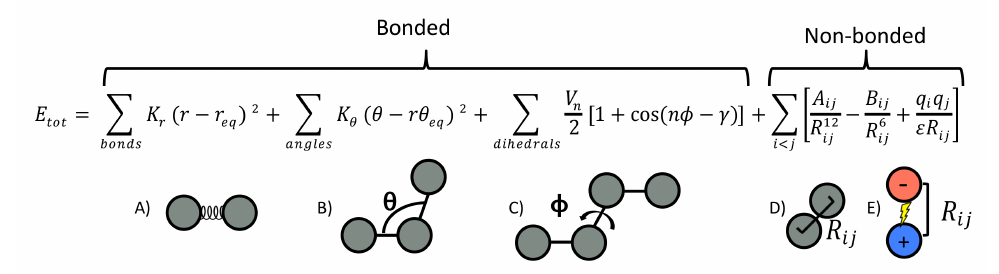
Figure 1. A typical force field (FF) model. Energy dependencies are related to (a) stretching or compressing a bonded pair of atoms (modeled by a simple spring) (b) Increasing or decreasing the bond angle (modeled by a simple spring) (c) dihedral angle rotations (modeled by a sinusoidal function) (d) Van der Waals interactions (modeled by Lennard–Jones potential) and (e) Electrostatic interactions (modeled by Coulomb’s law). (a–c) are caused by interactions between atoms that are chemically bonded to one another while (c–e) are caused by interactions between atoms that are not